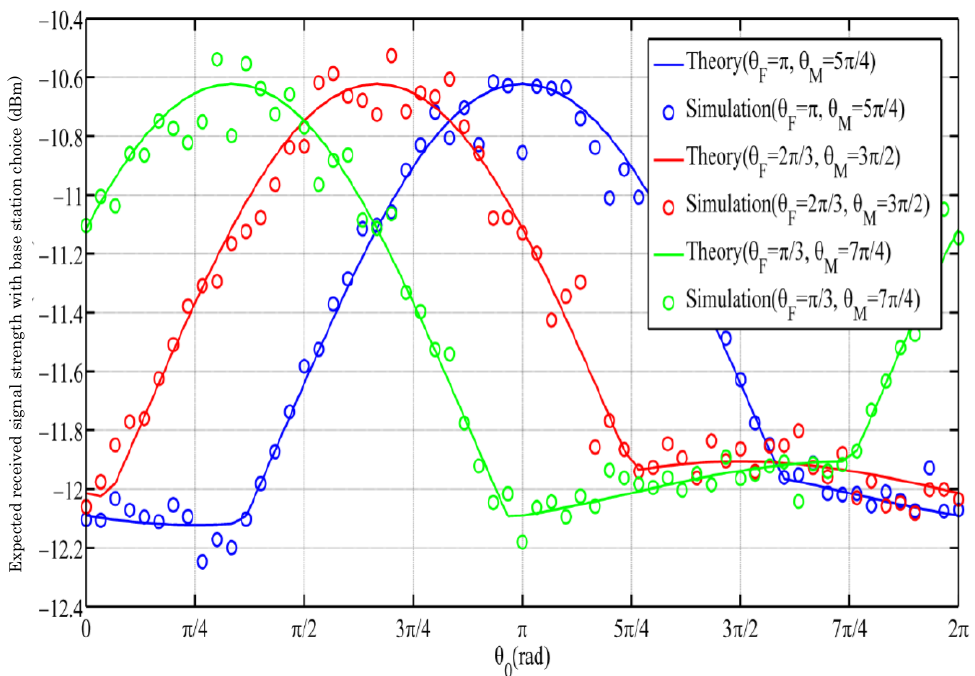
Figure 15. When r = 30 m/s, expected RSS with base station